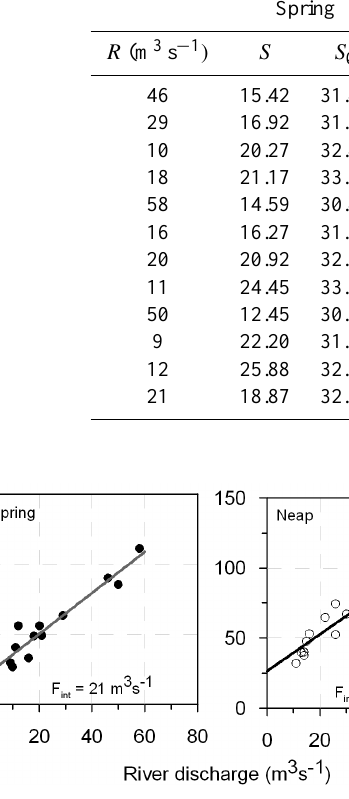
Fig. 8. Plot of the flushing rate ( F ) calculated for the average salin- ity of the Sumjin River Estuary against the river discharge ( R ) dur- ing spring and neap tides. The intercept value, F int , denotes the tide-driven exchange. The amounts in excess of F int for the vari- ous river discharges indicate the gravitational circulation exchange ( G c